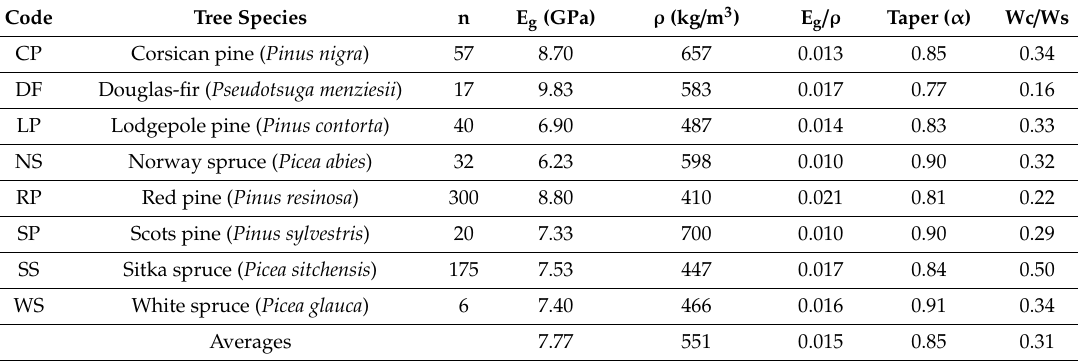
Table 1. Average values of wood properties (modulus of elasticity of green wood, E g , and density ρ ), tree taper ( α ) and the ratio of crown mass to stem mass (Wc / Ws) for each species used in the analysis to estimate fundamental natural sway frequency. The number of trees (n) for which sway data were obtained from the literature is also